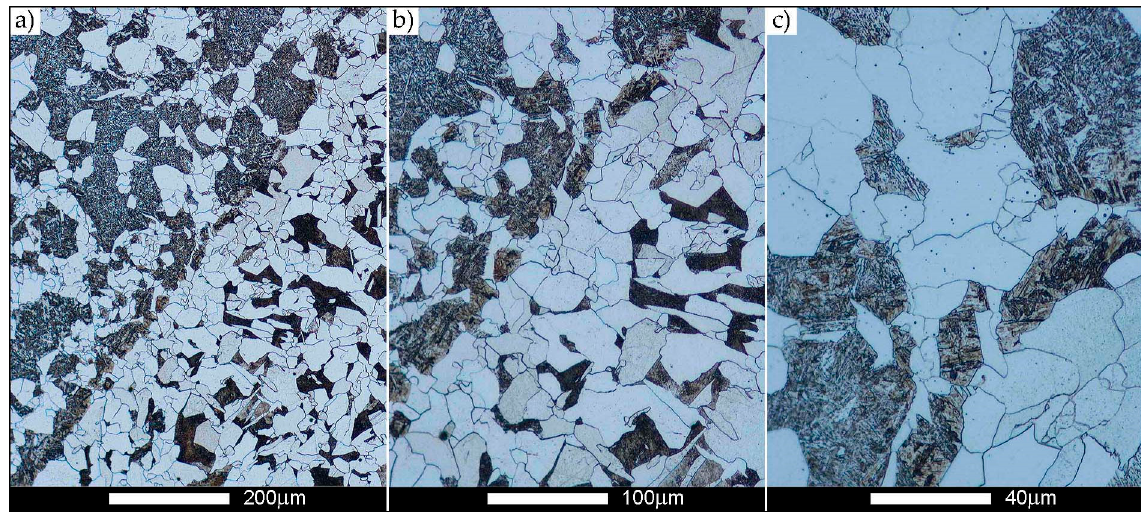
Figure 54. Welded joint microstructure of Hardox 450 steel with visible prior austenite grain boundaries, austenitised at 1100 °C—FL zone shown in Figure 2. ( a ) 100×; ( b ) 200×; ( c ) 500×.